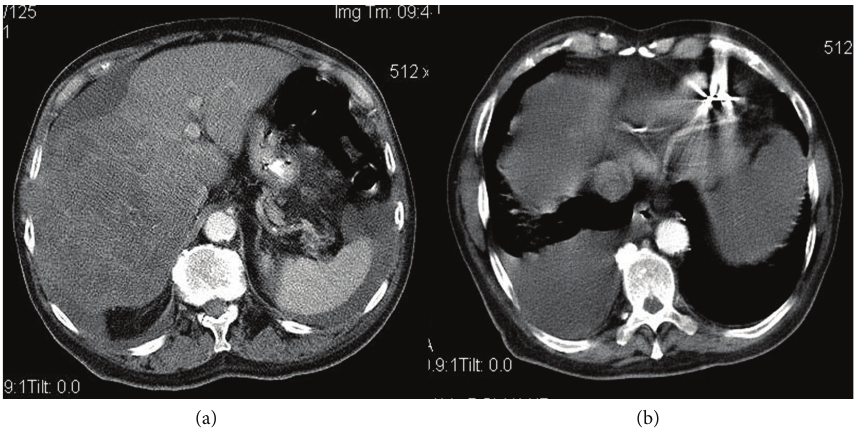
Figure 1: Contrast enhanced CT scan of thorax, abdomen, and pelvis.